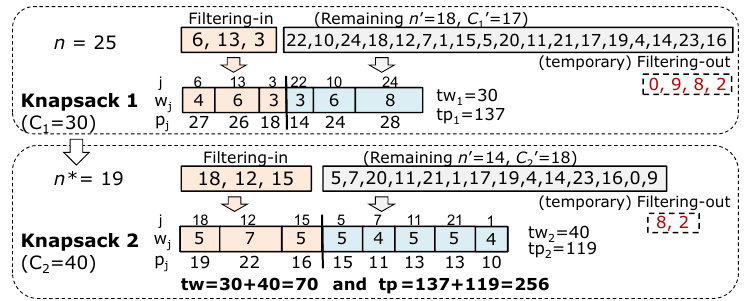
Figure 13. An example ( n = 25, m = 2, C = (30, 40)) and object classification for knapsack 1 ( K 1 ).